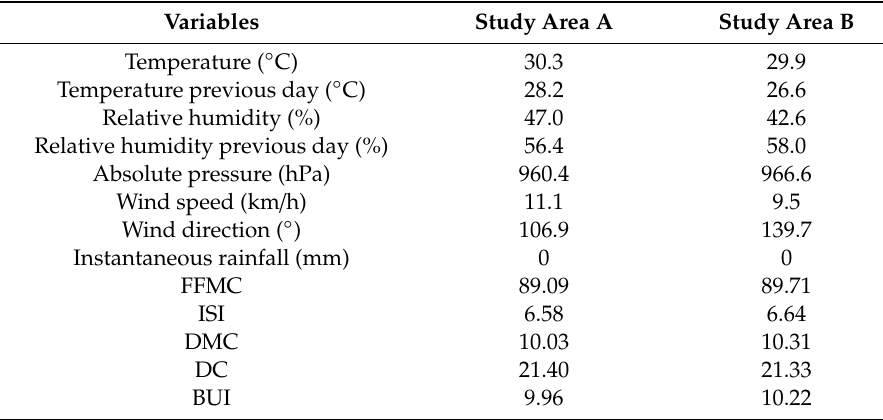
Table 3. Results of the FWI calculated